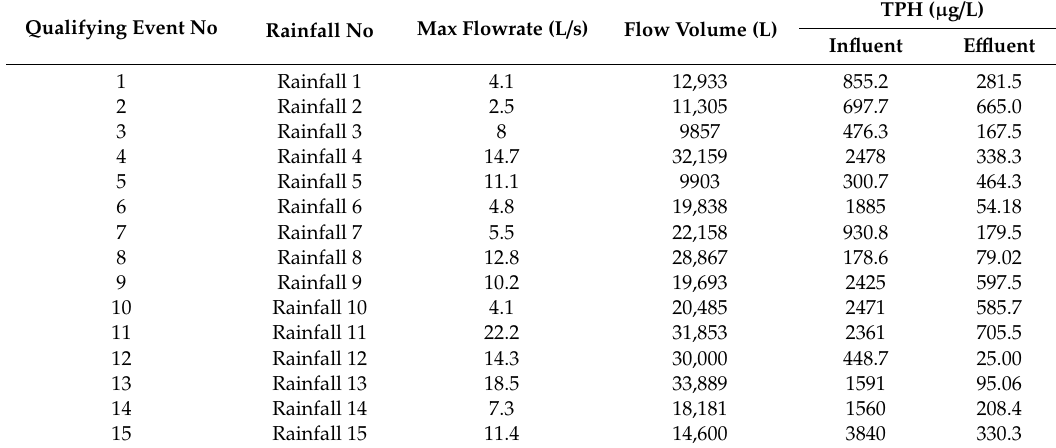
Table A5. TPH influent and e ffl uent results ( LOD = 50 µ g / L).